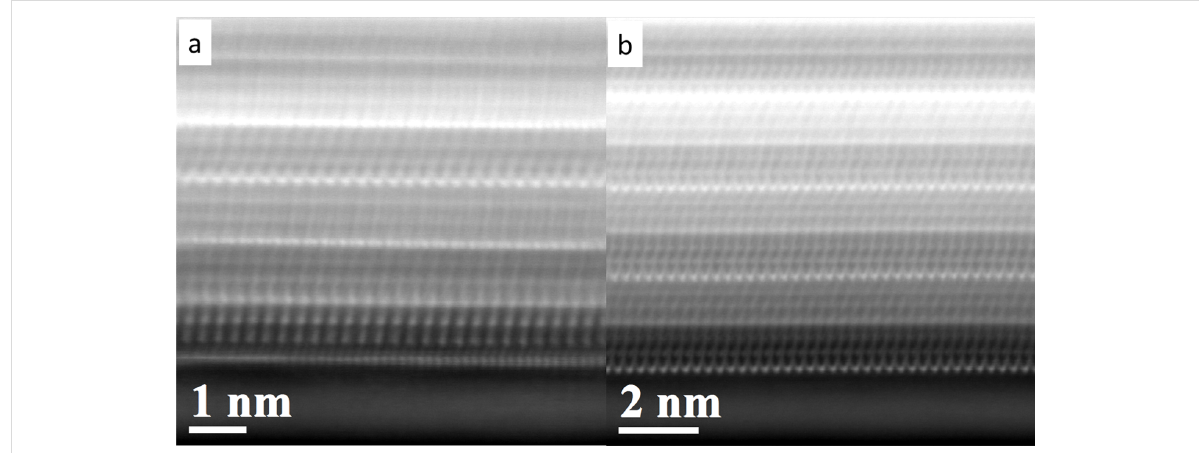
Figure 6: (a,b) HAADF-STEM images of a Sr x La 1 − x S–TaS 2 (20 atom % Sr in the precursor) nanotube showing multiple orientations of TaS 2 layers.